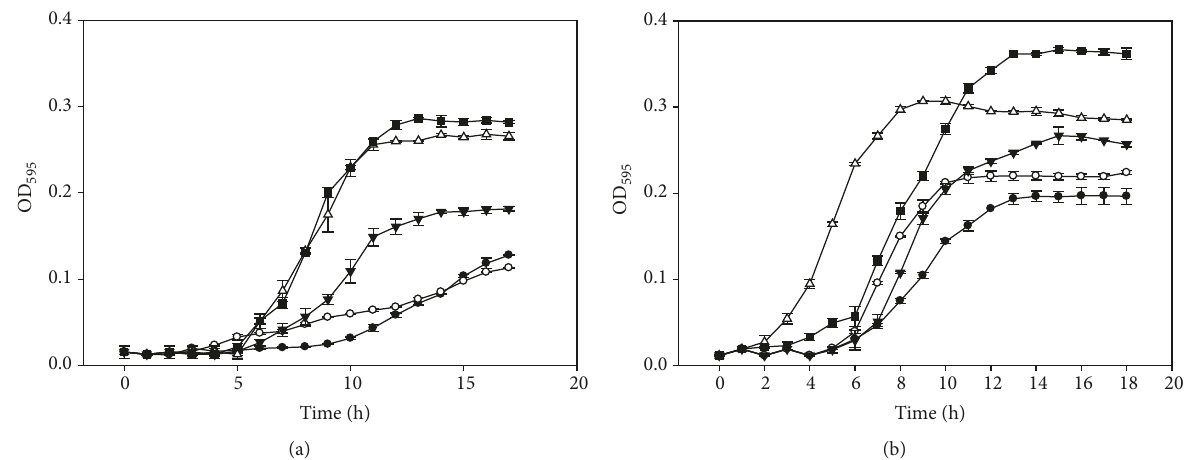
Figure 2: Benzoyl peroxide (a) and salicylic acid (b) activity against L. monocytogenes . Benzoyl peroxide 250 𝜇 g/mL ( e ), 125 𝜇 g/mL ( I ), 62.5 𝜇 g/mL ( 󳶃 ), 31.3 𝜇 g/mL ( Δ ), and 0 𝜇 g/mL ( ◼ ). Salicylic acid 250 𝜇 g/mL ( e ), 125 𝜇 g/mL ( I ), 62.5 𝜇 g/mL ( 󳶃 ), 31.3 𝜇 g/mL ( Δ ), and 0 𝜇 g/mL ( ◼ ).